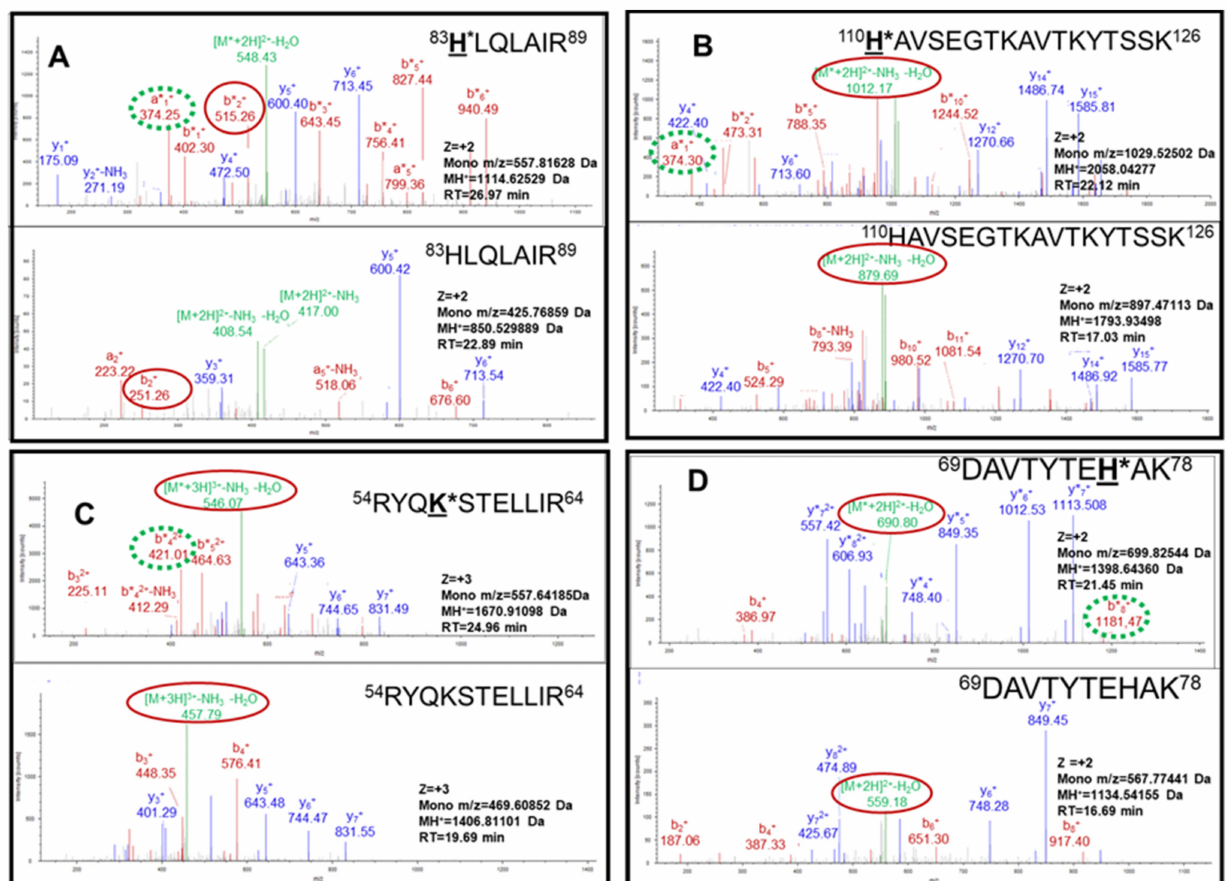
Figure 3. Mass spectra corresponding to representative unmodified peptides and their nevirapine (NVP)-modified coun- terparts from histones H2A ( A ), H2B ( B ), H3 ( C ), and H4 ( D ). Asterisks (*) indicate NVP-modified residues. Selected red outlines represent fragment ions from NVP-modified peptides and their unmodified counterparts that clearly indicate the NVP mass increment. Dashed green outlines correspond to diagnostic fragment ions that attest the modification